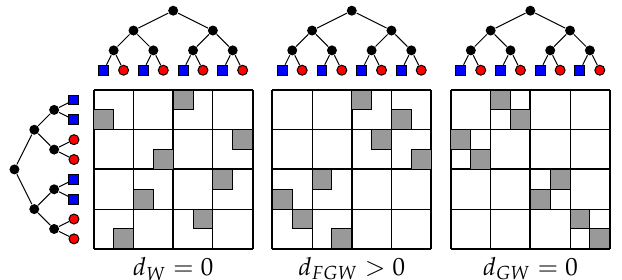
Figure 8. Difference on transportation maps between FGW , GW , and W distances on synthetic trees. ( Left ) the W distance between the features is null since feature information are the same, ( Middle ) FGW with α ∈ ] 0,1 [ is different from zero and discriminate the two structured objects, and ( Right ) GW between the two isometric structures is